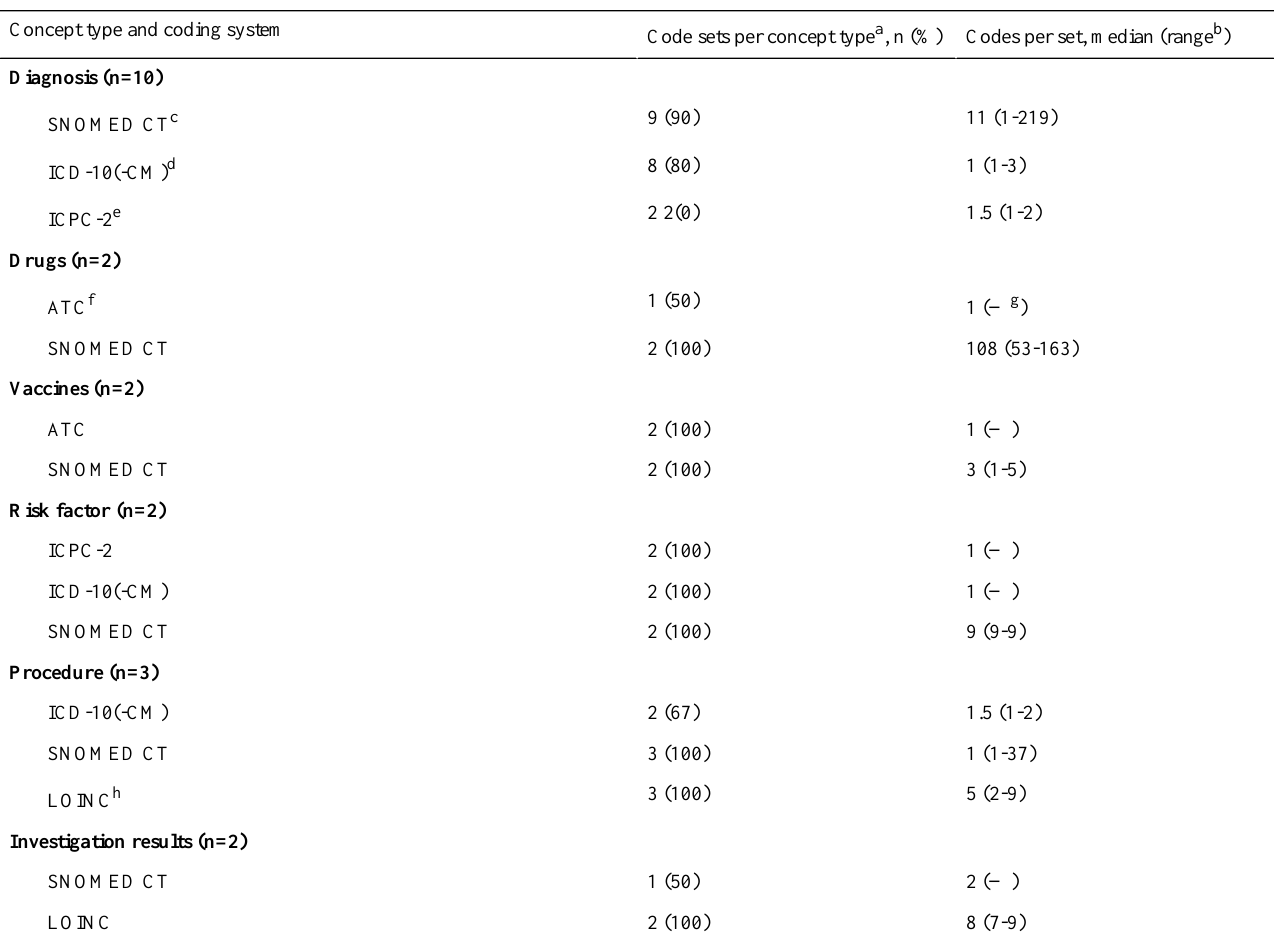
Table 2. Code sets identified from 3 preventive care